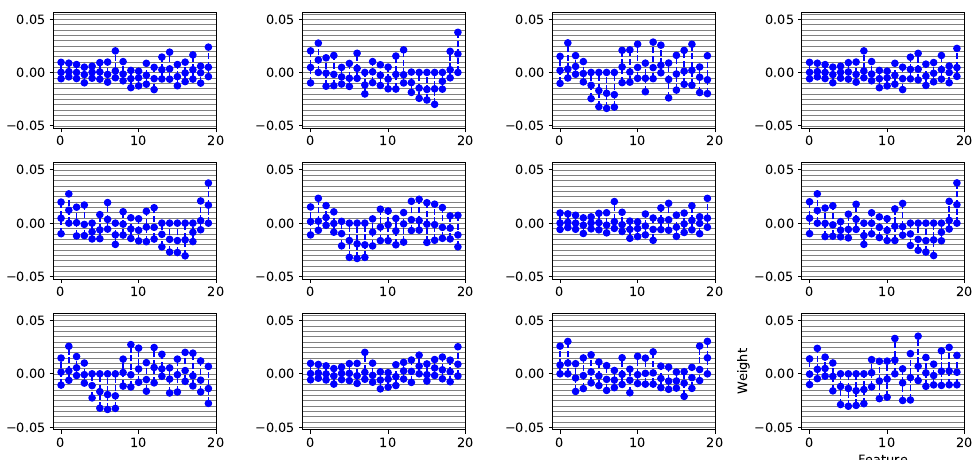
Figure 8. Confidence interval at 95% of the ν -SVM weight for each statistic computed over the non-normalized QRS from the 12 leads for HCM-DB. Each panel shows the statistics for one principal component. Blue lines correspond to weights the confidence interval of which overlap the